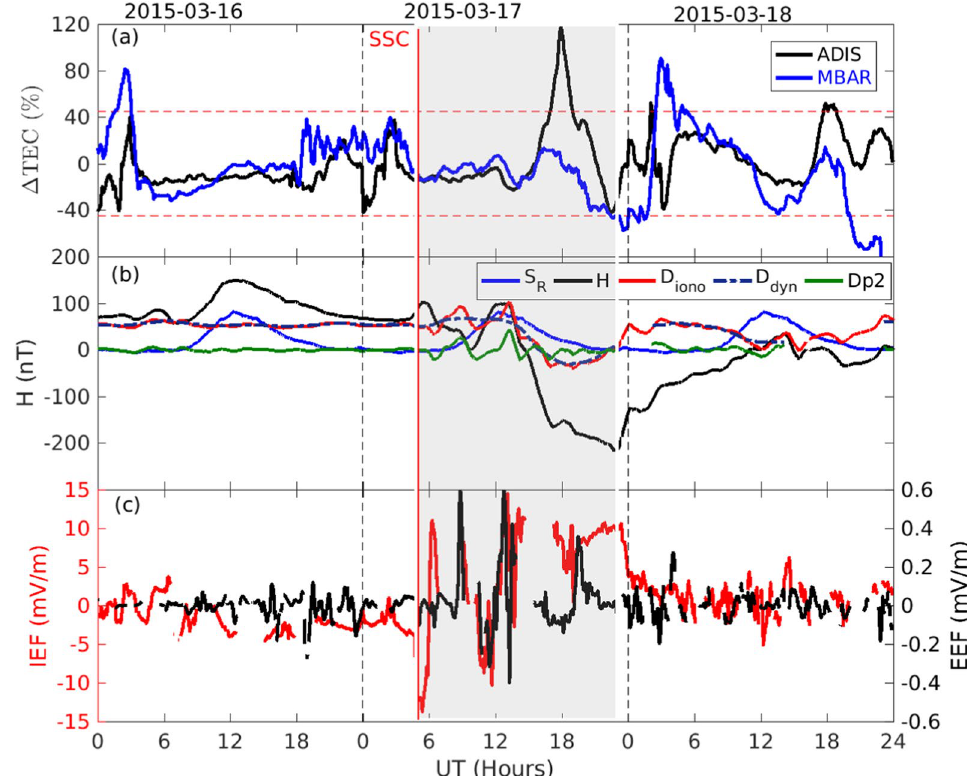
Fig. 4 Same as Fig. 3 but for a severe geomagnetic storm of 16–18 March